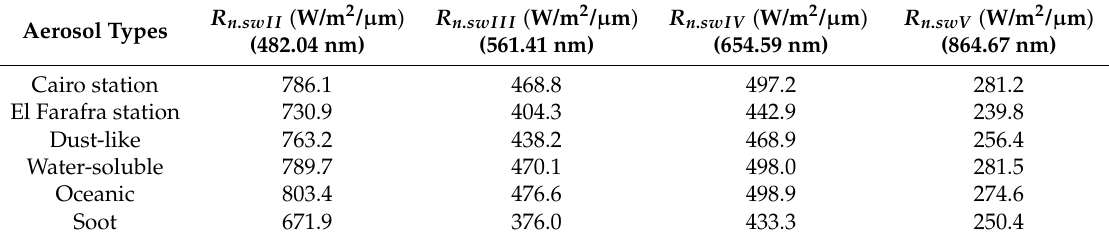
Table 7. R n . sw averaged by pixels at Landsat spatial resolution over the study area. The R n . sw is reported for the OLI channels (the second to the fifth) overlapping the MODIS channels. Aerosol Types